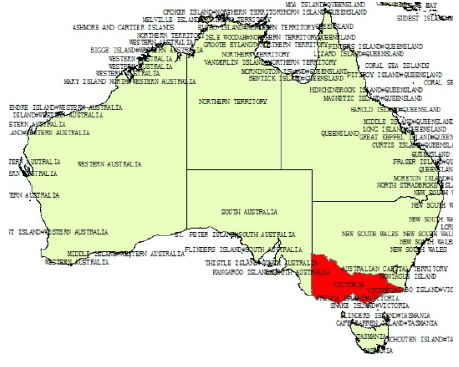
Figure 1. The location of Victoria in Australia